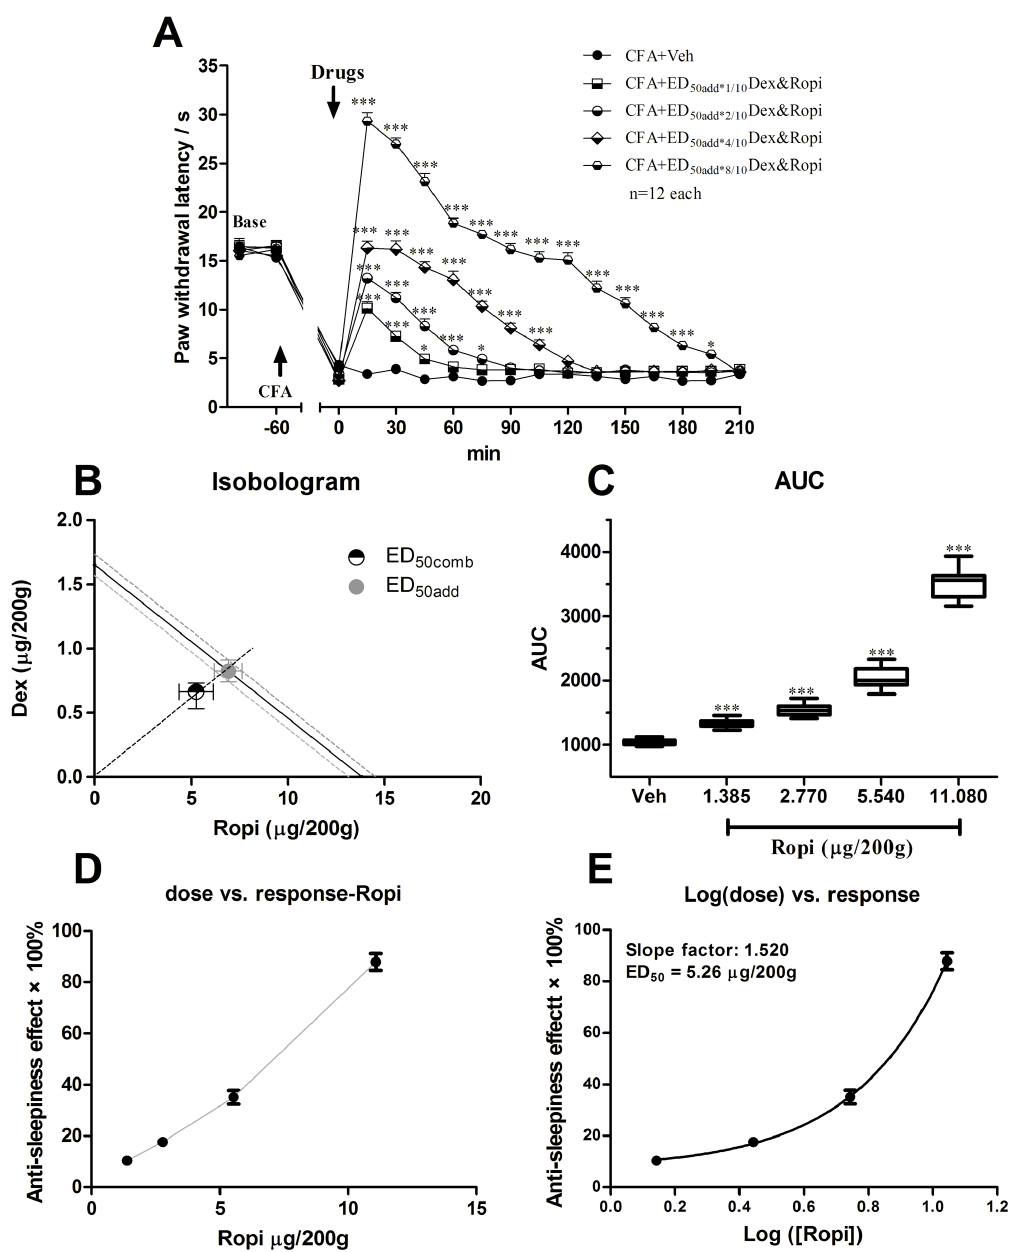
Figure 3. i.t. Dex and Ropi combinations dose-dependently inhibited CFA-induced thermal hyperalgesia of the injected hind paw. i.t. Dex and Ropi combinations dose-dependently prolonged analgesia duration ( A ). Iosobologram for combination analgesia was shown in B . The AUCs for different groups were calculated to perform statistical analysis ( C ). The dose-effect or log (dose)-effect curves for combination analgesic effects were shown in D and E . * p , 0.05; *** p , 0.001, compared with CFA-Veh group; arrows indicated s.c. CFA injection and i.t. intervention time point, respectively.